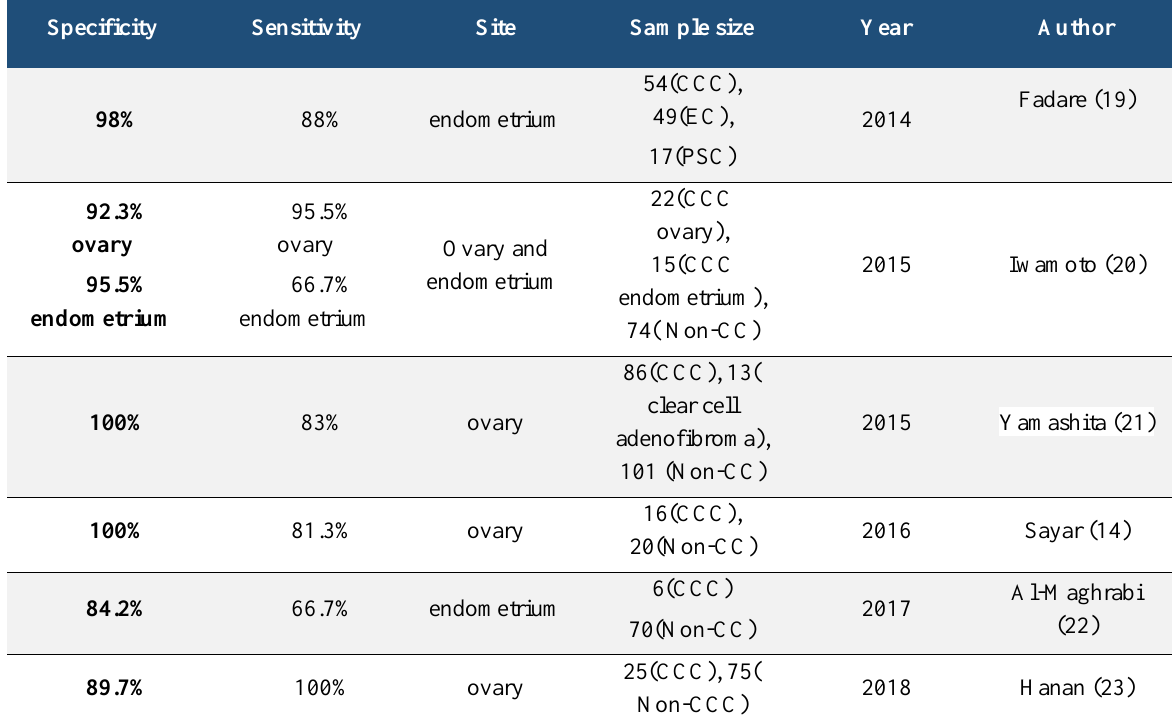
Table 2. Review of previous studies evaluating diagnostic accuracy of Napsin-A in ovarian and endometrial clear cell carcinoma.